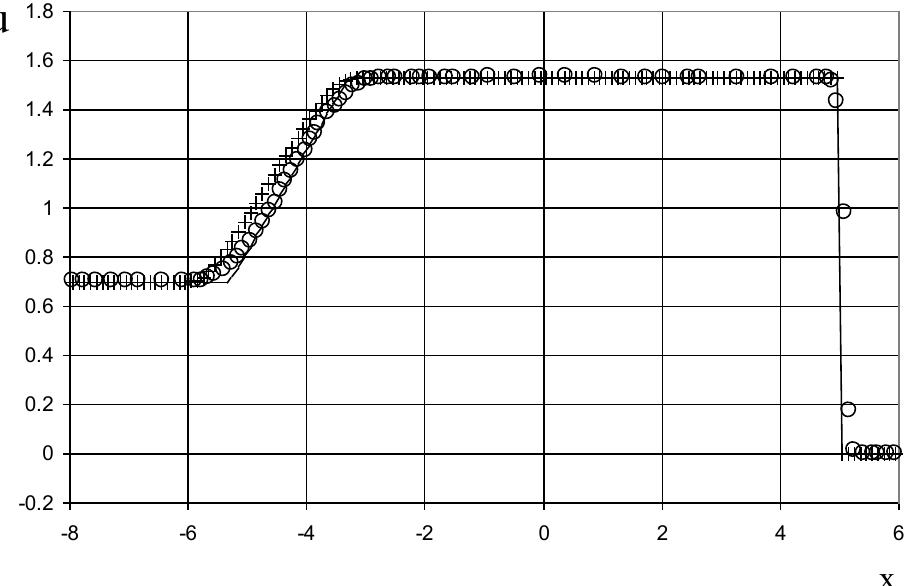
Figure 14. Density plot for the Riemann problem of Lax: the exact solution (line), the ULT1C scheme of Harten (circle), and the present method (cross).